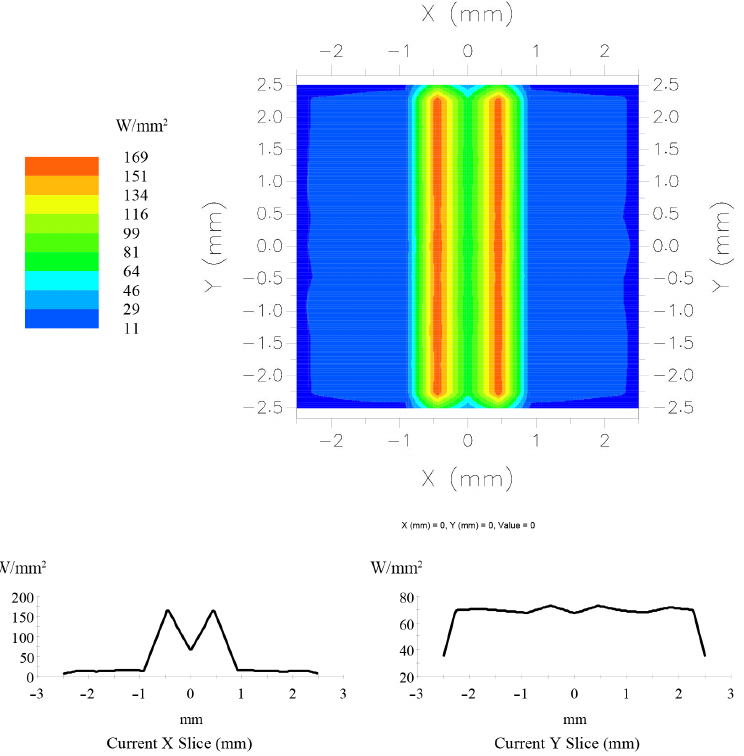
Figure 9. Simulation results without reflective grooves showing nonuniform illumination over the solar cell.